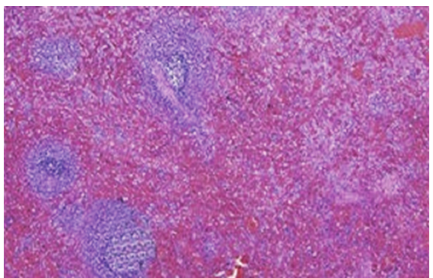
Figure4:Microscopicpictureconfirmingspleenshowingwhiteand red pulp in mass. (H&E stain × 400